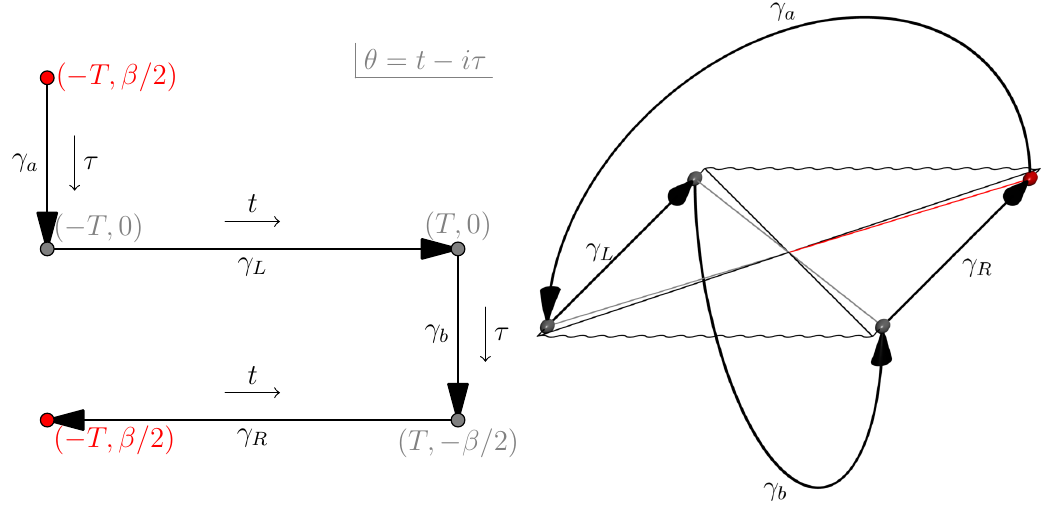
Figure 3. The thermal Schwinger-Keldysh contour in CFT 2 (left) and the mixed-signature bulk spacetime, corresponding to it (right). On the boundary contour (left), the grey dots signify gluing between an Euclidean and a Lorentzian segment and the red dots at ( − T, ± β/ 2) are identified and also glued. On the bulk contour (right) the fields are glued at fixed time slices extending all the way into the bulk until the horizon at r = r + is